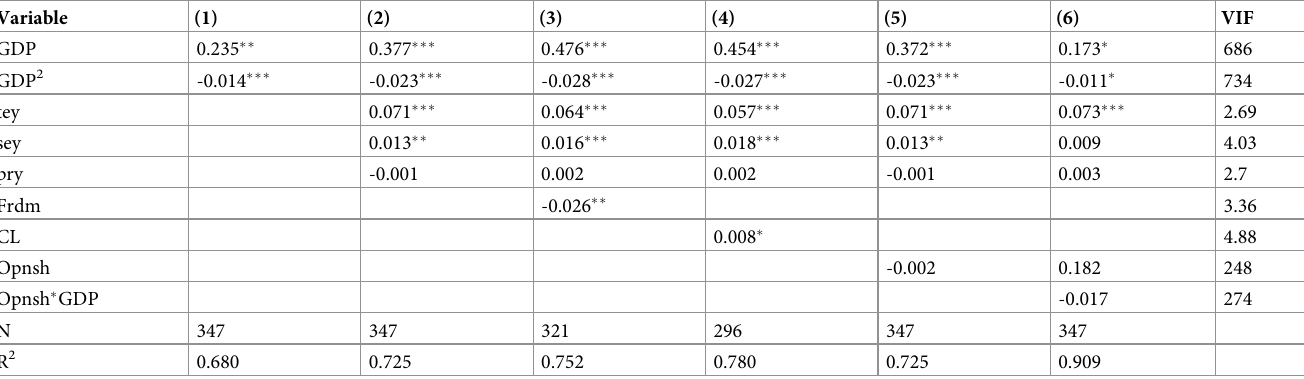
Table 6. Replication results for Barro (2000) using the original panel